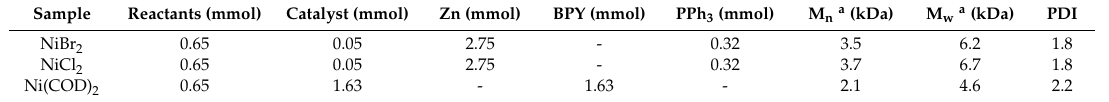
Figure 3. 1 H NMR spectra of (3,5-dichlorophenyl)-(2,4-dimethylphenyl)methanone (3,5-DCDMPM) and Product 2 synthesized using NiBr 2 , NiCl 2 , or Ni(COD) 2. Table 2. Product 2 syntheses and molecular